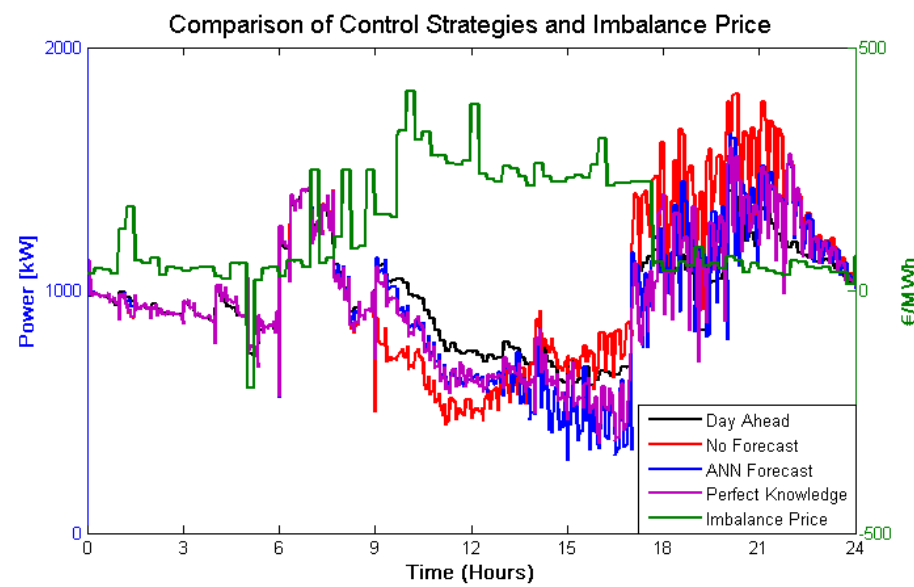
Figure 14. Total allocations for all trade strategy approaches and the imbalance price.